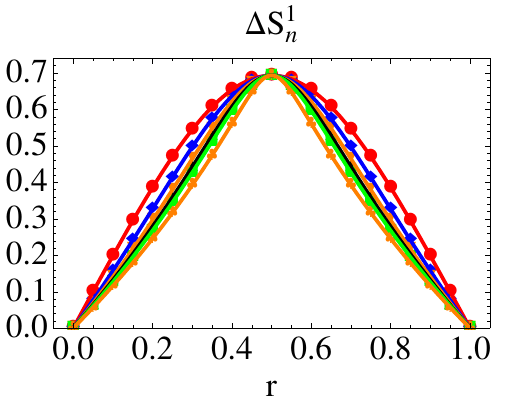
Figure 4 . Comparison between analytic results (continuous curves) and numerical values (dots) of the R(cid:19)enyi entropies for a single particle excited state. We show the R(cid:19)enyi entropies from n = 2 (red) to n = 11 (orange), with momentum P = 100 (cid:25) .